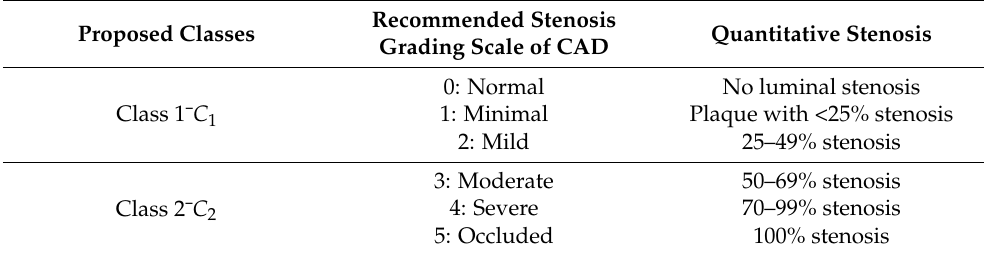
Figure 1. Flow chart depicting the distribution of the cohort in CAD-severity groups based on the CTCA imaging at the follow-up step. in total, 287 patient imaging data (125 in Class 1 and 62 in Class 2) were analyzed. (CAGB, coronary artery bypass graft surgery; CAD, coronary artery disease). Table 2. Definition of the utilized CAD risk classes. (CAD, coronary artery disease).